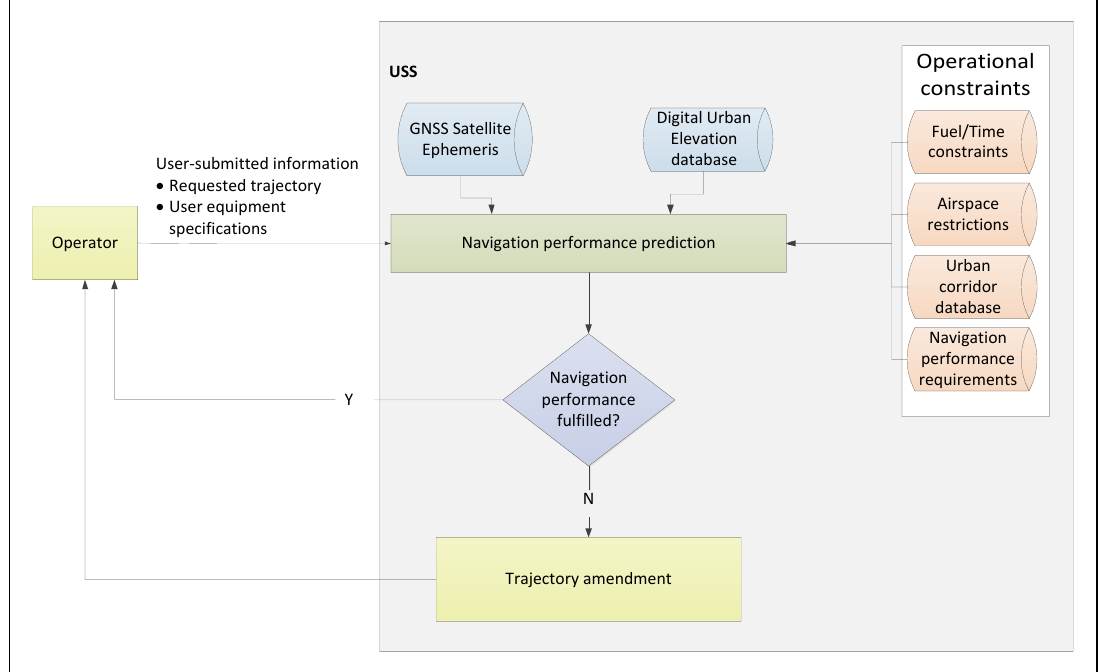
Figure 4. Proposed system architecture for GNSS-based UAM operations.